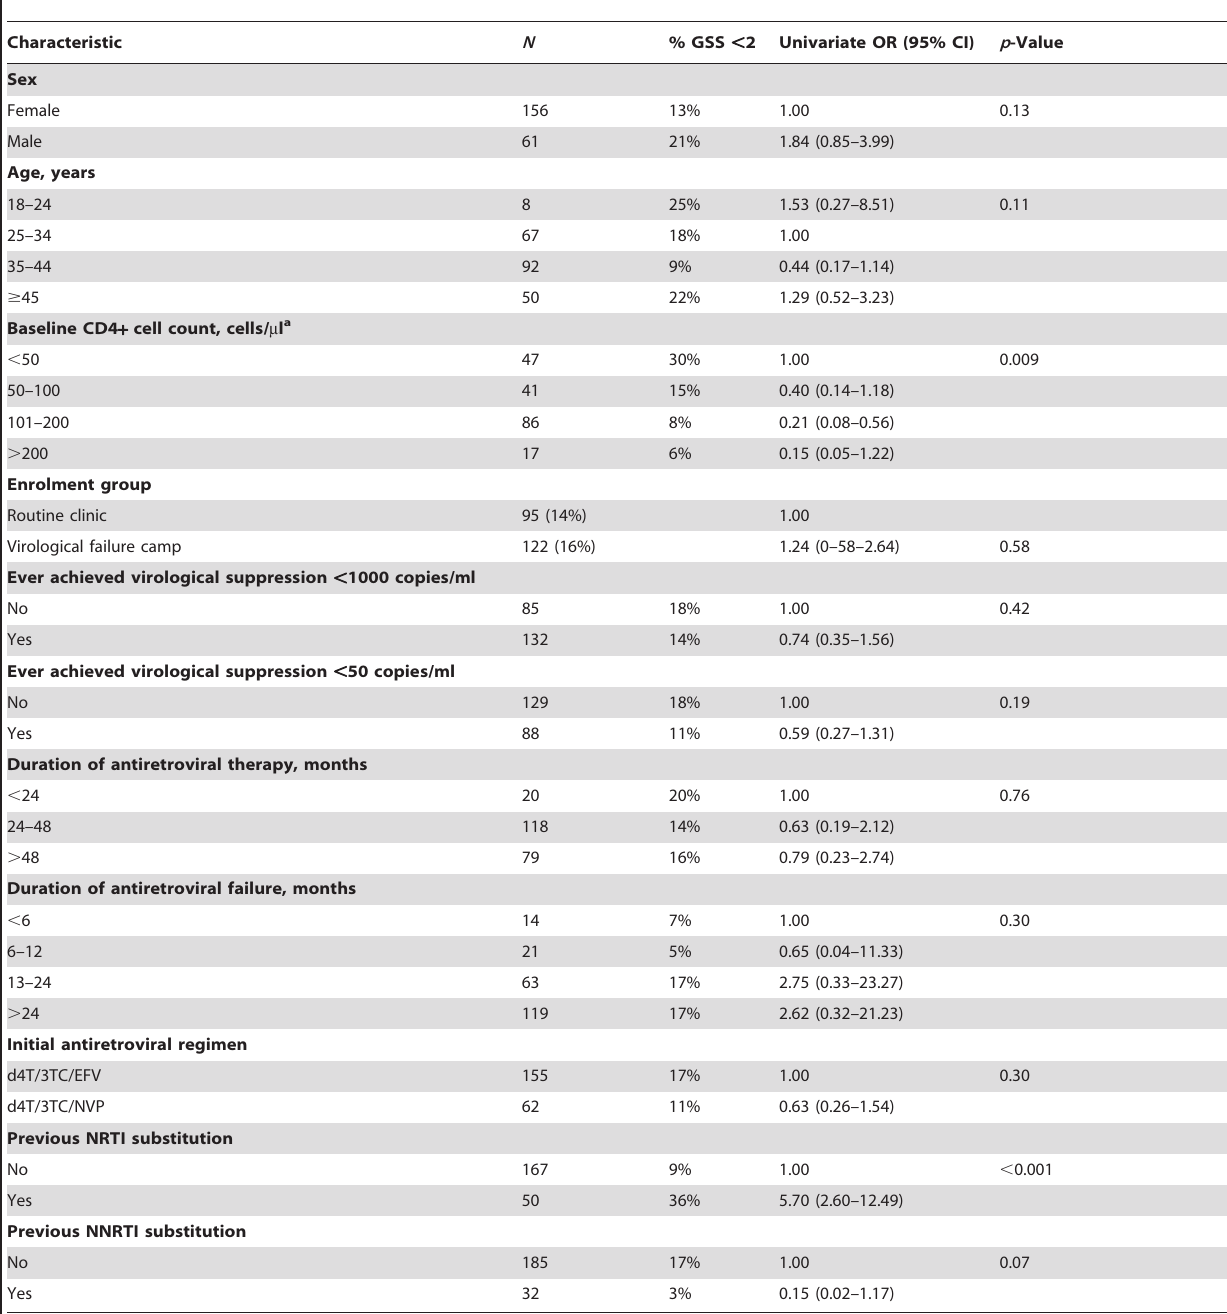
Table 2. Univariate analysis of factors associated with compromised standard second-line regimen (genotypic susceptibility score ,